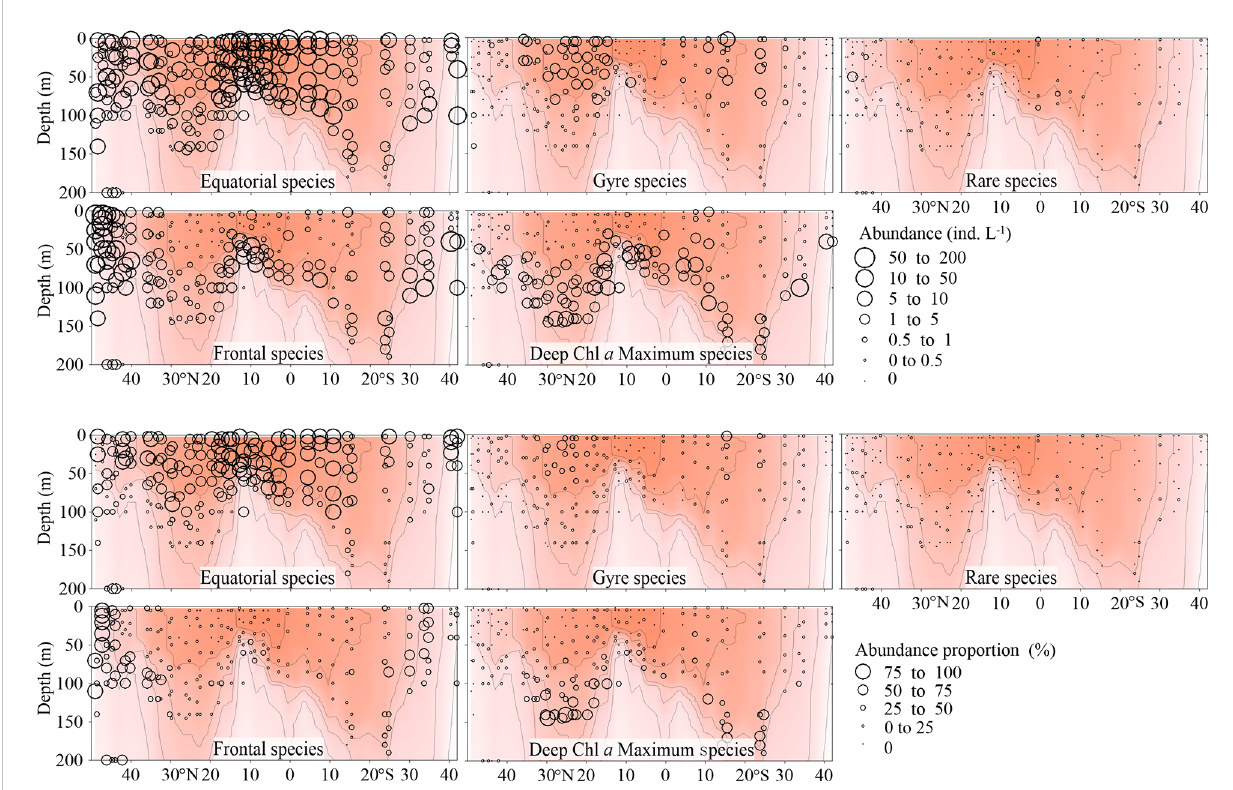
FIGURE 5 Vertical Tintinnina abundance (ind. L -1 , upper panel) and abundance proportion (%, lower panel) distribution in each biogeographic region along the AMT transect. The red color and isothermal lines are temperature (°C) as in Figure 2. Black dots denote the locations of sample